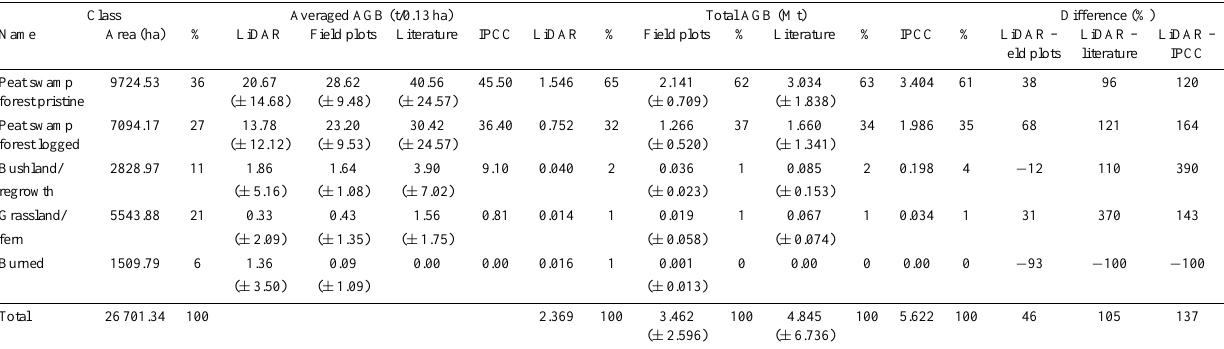
Table 1. Above-ground biomass (AGB) comparison between the LiDAR-based estimations and AGB estimations where AGB values were based on site-specific field inventory data (field plots), regional literature estimates (literature), and IPCC default values (IPCC), according to land cover classes, derived from a Landsat (multispectral satellite) classification, for the peatlands within the LiDAR stripes of the 1millionha study area (Mt =